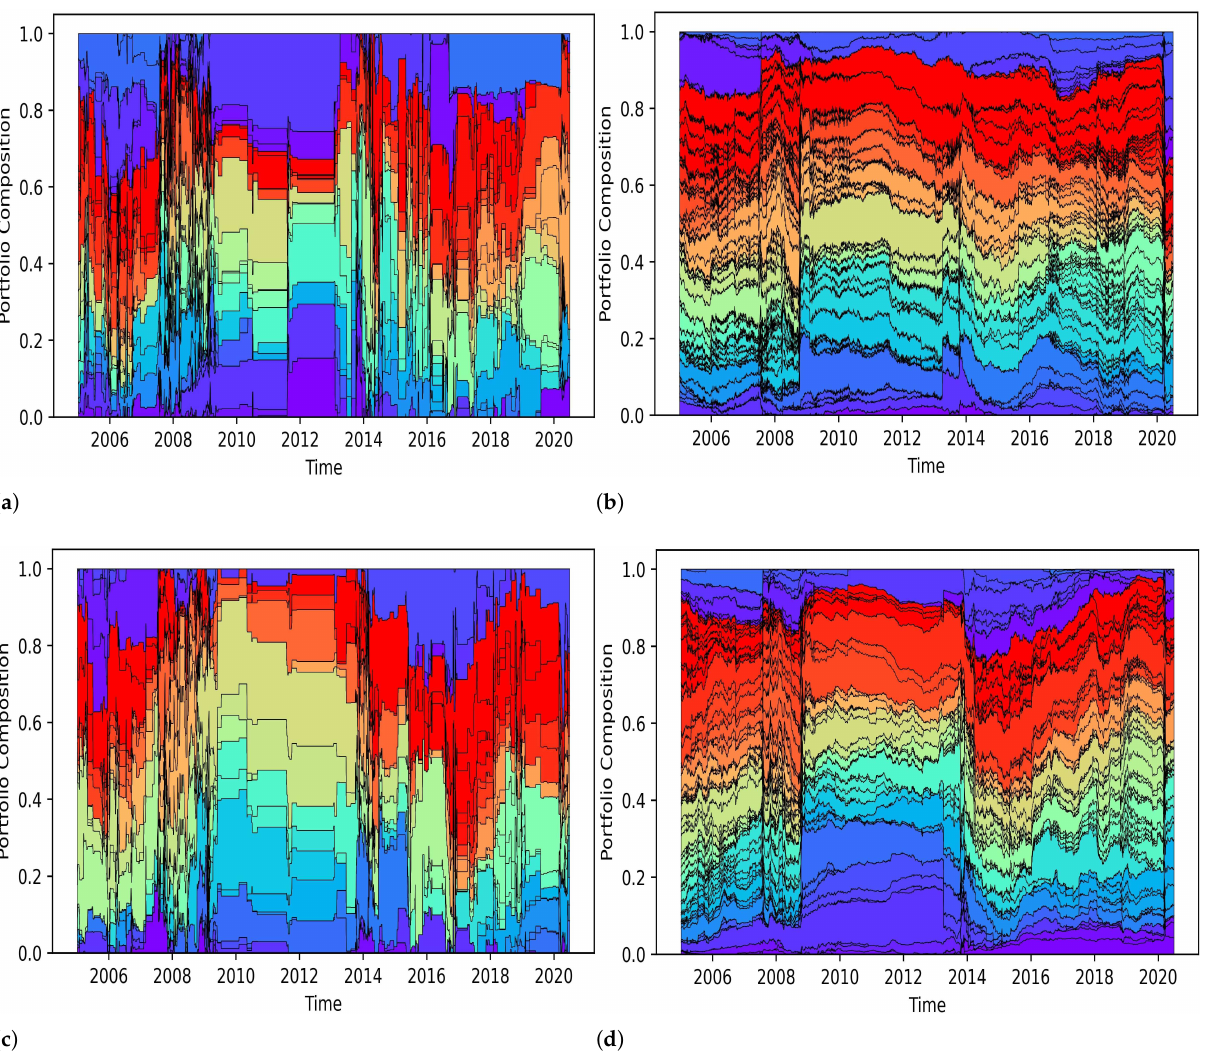
Figure 7. Optimal weights under the strategies DR, MV, ERI, and MDP for the 361-stock portfolio over the backtest period. ( a ) DR; ( b ) MV; ( c ) ERI; ( d )